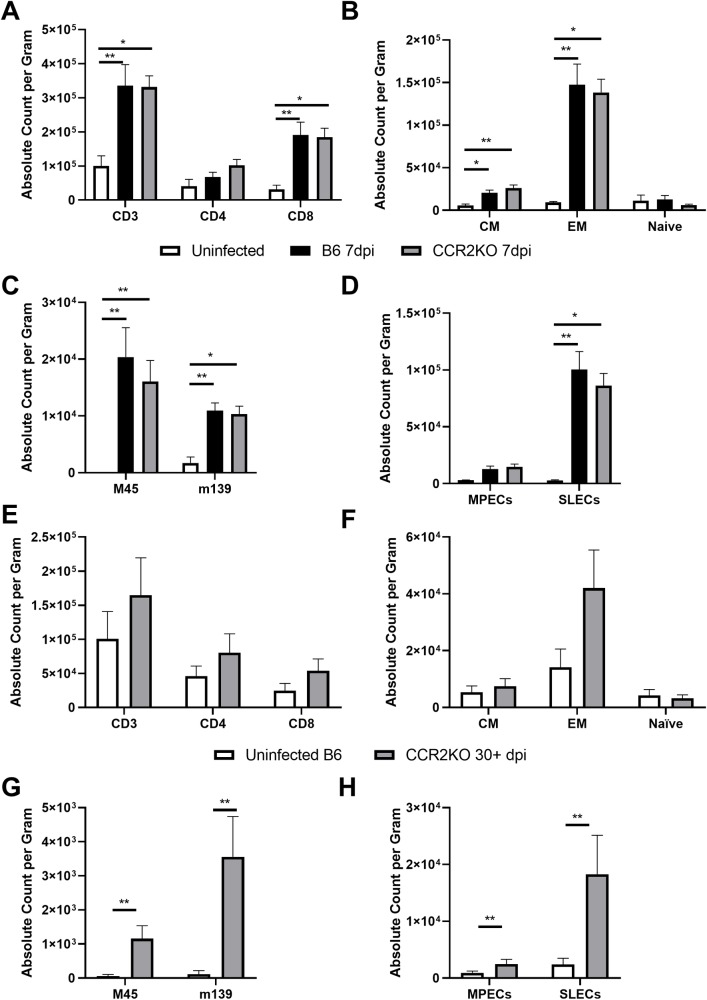
Adipose tissue accumulates CD8+ mCMV-specific CD8 T cells regardless of the route of infection or the presence of CCR2+ cells.12-week-old C57BL/6J and CCR2-/- mice were infected with 105 pfu of mCMV via the footpad and sacrificed at 7d p.i.. Stromal vascular fraction was analyzed by flow cytometry. (A–D) 7d p.i. (A) Total number of T cells and subsetted into CD4 and D8 pools. (B) CD8 T cells were phenotyped based on expression of CD62L and CD44 and quantified. (C) CD44+ CD8 T cells were analyzed for mCMV specificity by tetramer staining. (D) CD44+ CD8 T cells were analyzed for expression of KLRG1 and CD127 to quantify number of MPECs and SLECs. (E–H) 30d + p.i. (E) Total number of T cells and subsetted into CD4 and D8 pools. (F) CD8 T cells were phenotyped based on expression of CD62L and CD44 and quantified. (G) CD44+ CD8 T cells were analyzed for mCMV specificity by tetramer staining. (H) CD44+ CD8 T cells were analyzed for expression of KLRG1 and CD127 to quantify number of MPECs and SLECs. Data are pooled results of two independent experiments. (A–B) n = 5 uninfected, 10 C57BL/6J infected, 10 CCR2-/- infected animals total. (E–H) n = 6 uninfected and n = 6 infected. Error bars represent mean ± SEM. *p < 0.05; **p < 0.01; ***p < 0.001; **** p ≤ 0.0001. 7d p.i. are tested by Kruskal-Wallis with Dunn’s multiple comparisons and 30d+ p.i. by unpaired two-tailed Mann-Whitney U test.